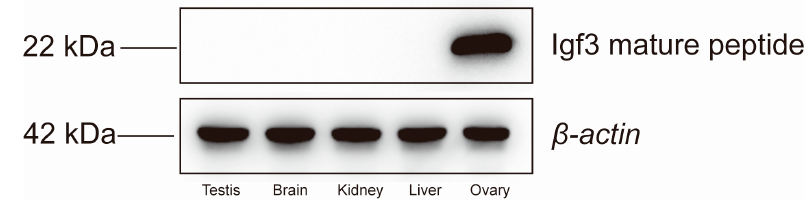
Figure 1. Western blot verification of